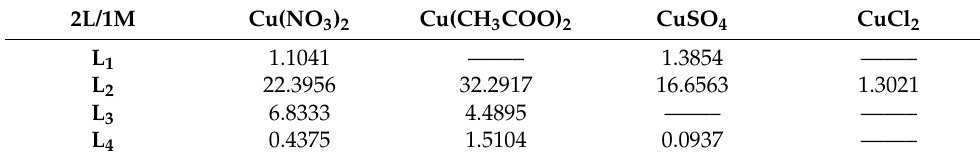
Table 2. The rate of oxidation of catechol in methanol ( µ mol · L − 1 · min − 1 ) (2L/1M). 2L/1M Cu(NO 3 ) 2 Cu(CH 3 COO) 2 CuSO 4 CuCl 2 L